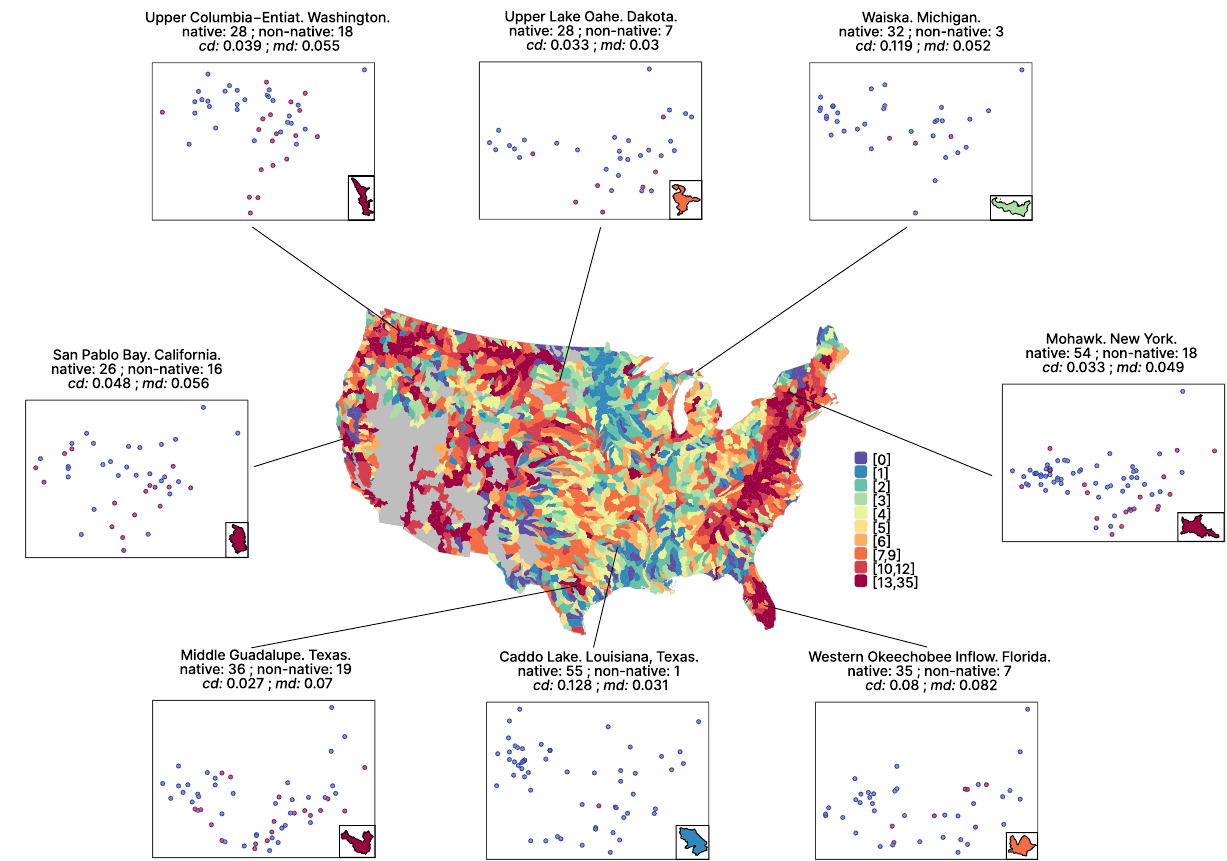
Fig. 4 | Pattern ofnon-native fi shspecies in the1868 watershedsin theUS. The mapshowsthenumberofnon-native fi shspeciesinthe1868watershedsintheUS. Scatter plots around the map show some examples of the position of native (blue dots) and non-native (red dots) species in a 2-dimensional functional space. The